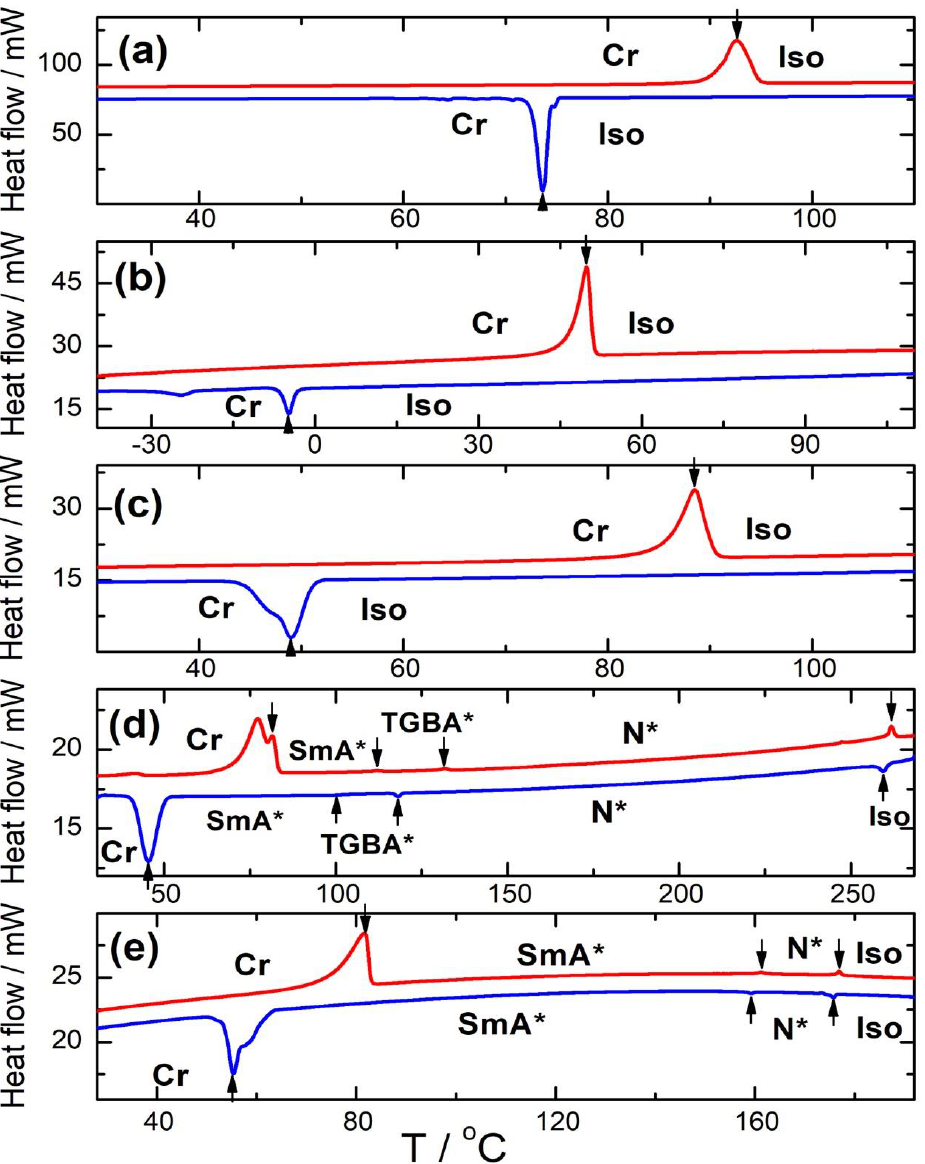
Figure 3. DSC plots of the heating/cooling runs (red/blue curves, respectively) for: Ia ( a ), Ib ( b ), Ic ( c ), IIa ( d ), and IIb ( e ) materials. Vertical arrows indicate the peaks corresponding to phase transitions; all phases are indicated.